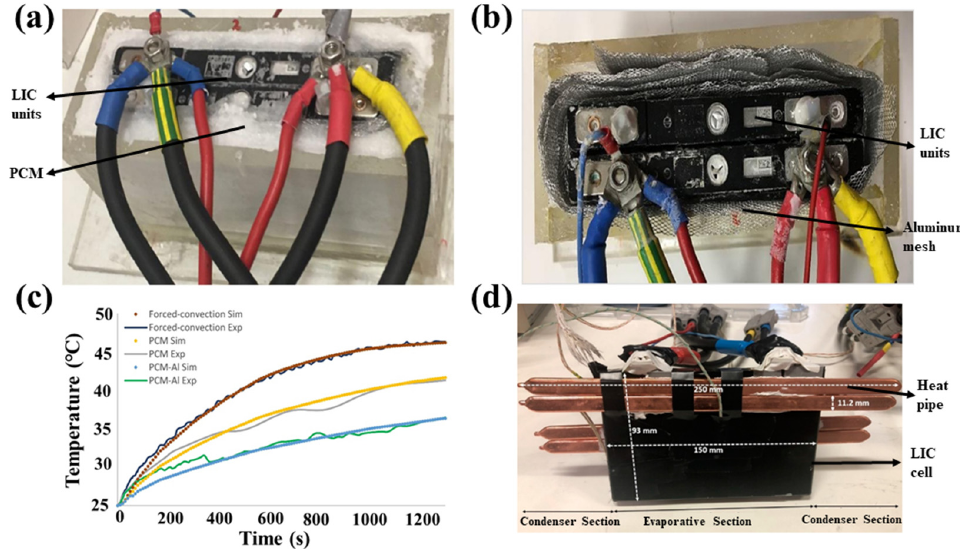
Figure 19. ( a ) Diagram of the thermal management system with LIC units and PCM. ( b ) The LIC units covered by aluminum mesh. ( c ) The temperature versus time plots for the various tests below: forced convection, PCM, and the PCM and aluminum mesh (PCM-Al) for LICs, reproduced with permission from [169]. Copyright 2020, Elsevier. ( d ) The HP cooling system for the LIC cell [170], open access.